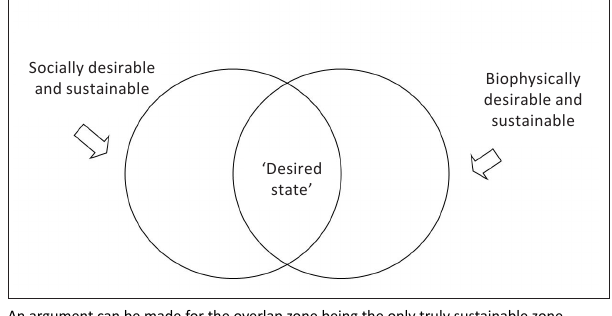
FIGURE 2: Desirable and sustainable biophysical and social domains, and the overall ‘desired state’ in their overlap